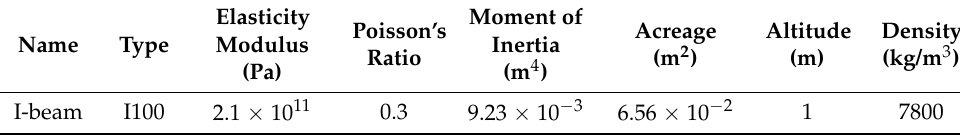
Table 2. Calculation parameters of the strengthened longitudinal beam.